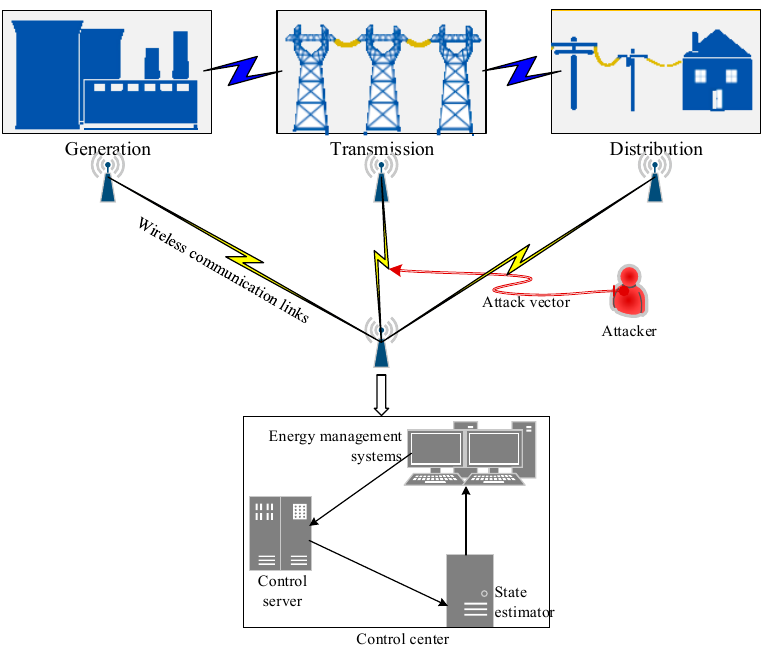
Figure 1. False data injection (FDI) attack on a smart grid (SG) system.